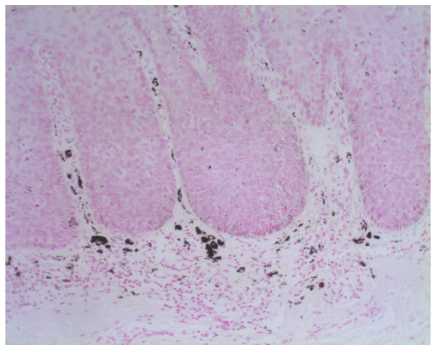
Figure 13: Case 2. Fontana Masson stain highlights melanin pigment in dendritic melanocytes and dermal melanophages, but not in